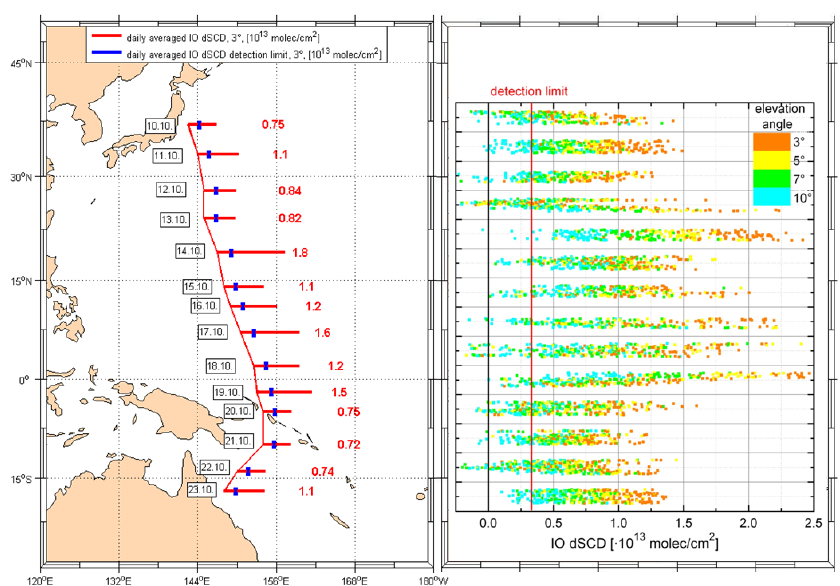
Fig. 5: Daily averaged IO dSCDs measured for elevation angles of 3 ◦ (red) along the cruise track with the dSCD detection limits displayed by blue bars (left panel). In the right panel, all inferred IO dSCDs are shown and colour-coded for different elevation angles. good agreement, for further analysis only the Heidelberg IO dSCDs were